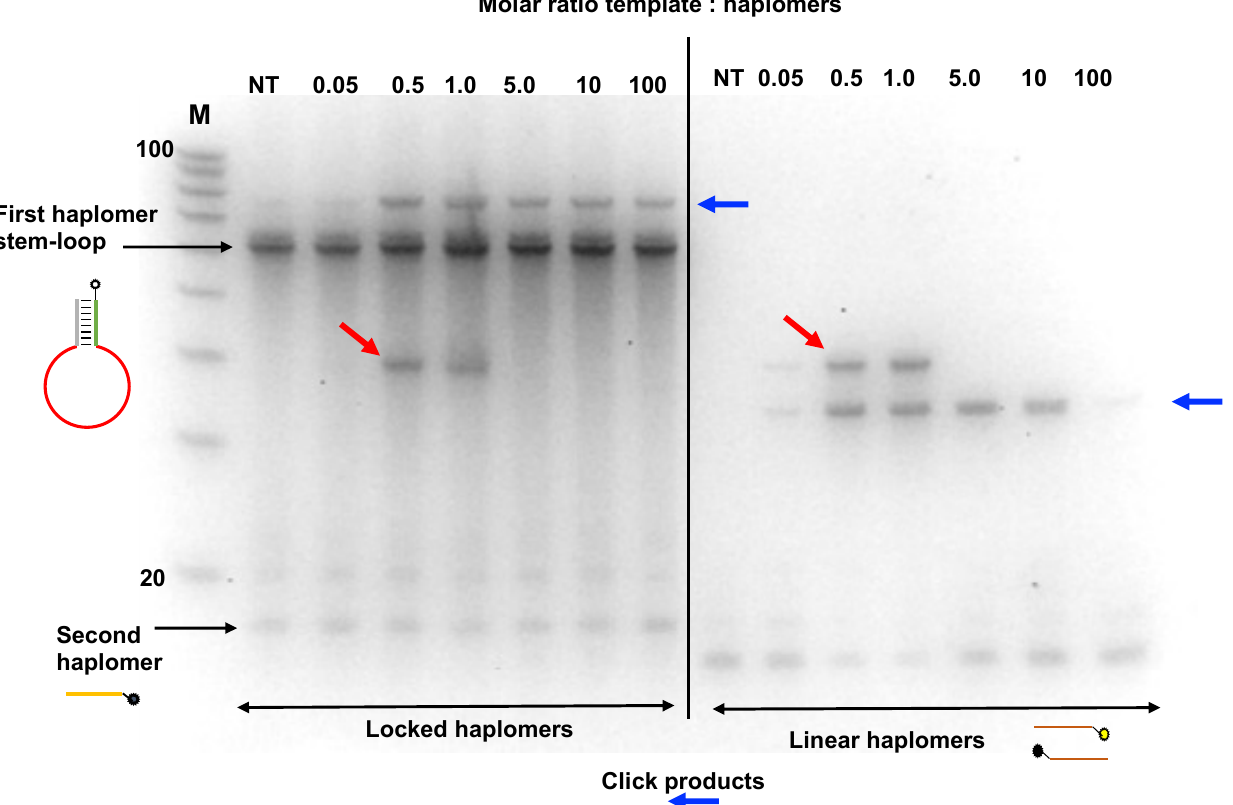
Figure 6. Locked-NATS strategy in conditions of template excess with an RNA template. The Locked-NATS click oligonucleotides as used in Figure 4 (First haplomer: 5 ′ -hexanyl-ACTCGAGACGTCTCCTTGTCTTTGCTTTTCTTCAGGACA CAGTGGCGAGACGTCTCGAGT; Second haplomer: TTTGACGTCTCGAGT-3 ′ azide) were tested with an RNA target template molecule (as shown by diagonal red arrows) corresponding to a truncated version of the HPV template DNA strand as also used in Figure 4. The same conditions as for Figure 4 were used with the First haplomer bottle in terms of quantities (50 pmol; 2 pmol/µL during template and second haplomer hybridizations; 0.4 pmol/µL during click reactions) and incubation times (2 h first haplomer bottle/RNA template annealings; 1 h for subsequent incubations with Second haplomer). Click reaction products are indicated with horizontal blue arrows. Locked-NATS reactions were compared with linear click haplomers directed to the same template (Lin-HPV1: 5 ′ -hexanyl-TCAGGACACAGTGGC; Lin-HPV2: TGTCTTTGCTTTTCT-3 ′ azide; detailed in Supplementary Figure S10). The RNA template was used in a range of molar ratios ranging from 0.05:1 (template:haplomers) to 100:1. Where the amount of RNA was equal to or greater than 5:1, it was necessary after the +/ − click reactions (performed in an identical manner as for Supplementary Figure S6) to remove the template with alkaline hydrolysis (Methods) prior to gel analysis, to avoid interference with band patterns. Samples (1.0 µ L) were run on denaturing 15% 8 M urea gels. NT = no template; M = 100/20 DNA size markers (IDT; 10-base decrements from 100